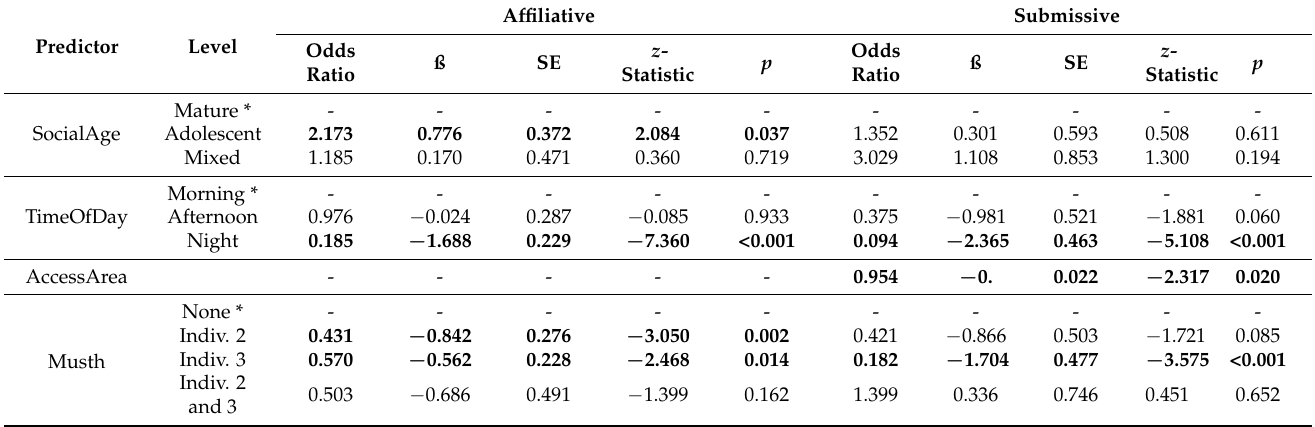
Table A7. Mature GLMER model parameter estimates for affiliative and submissive response vari- ables. Generalized linear mixed-effect model results of associations between predictor variables (fixed effects) and behavioral response variables for mature focal animals. ß = Beta coefficients from model outputs: positive values indicate an increase in odds compared to the reference level while negative values indicate a decrease in odds compared to reference level; SE = standard error of beta coefficients; Wald X 2 = Chi-squared statistic from Wald test with df = 1; p = p -value from Wald test. * indicates reference level. Bold signifies statistical significance ( p <